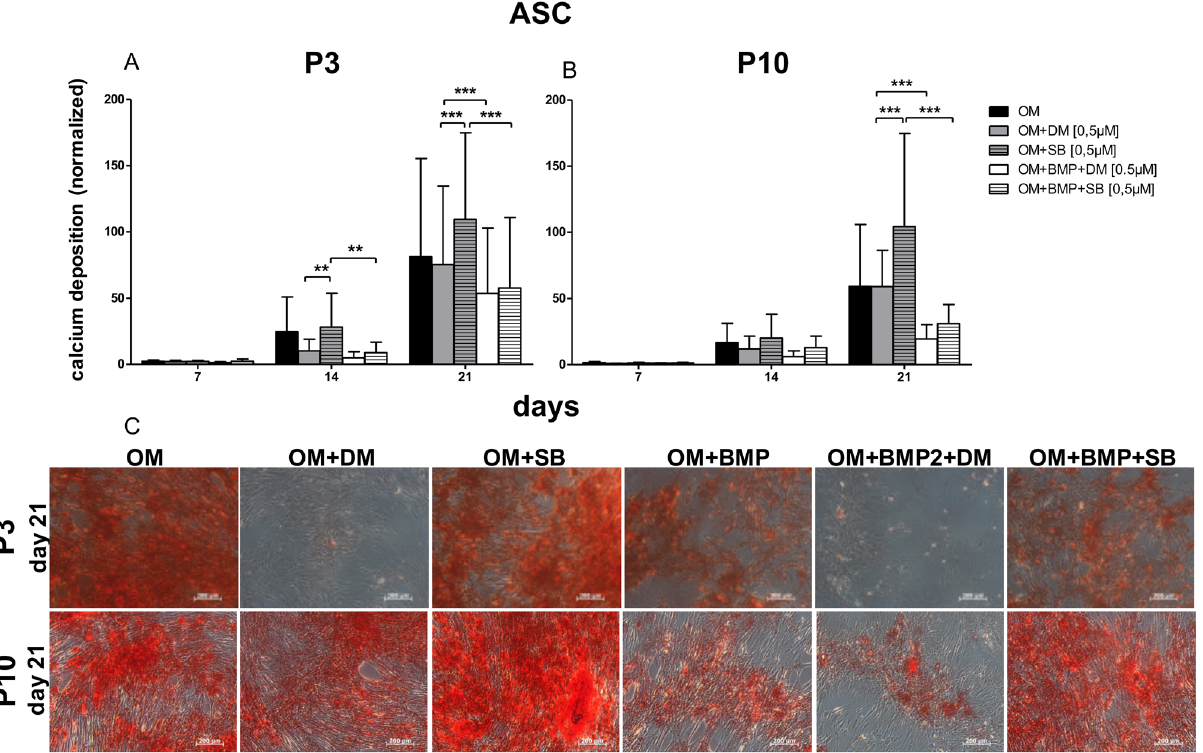
Figure 6. Comparison of the ASC osteogenic differentiation potential at P3 versus P10. ( A ) Evaluation of osteogenic differentiation potential in P3 with alizarin red s. At day 14 the inhibition of the TGF-β signaling with SB431542 (OM + SB) was significantly superior to the inhibition of BMP signaling with dorsomorphin (OM + DM). And the inhibition of the TGF-β signaling significantly was better than the inhibition of TGF-β signaling and the simultaneous induction of BMP signaling with BMP-2 (OM + BMP + SB). ( B ) Evaluation of osteogenic differentiation potential at P10 with alizarin red s. Inhibiting the TGF-β signaling with SB431542 (OM + SB431542) generated the best osteogenic differentiation potential, at day 21 and was significantly superior to an additionally application of BMP-2 (OM + BMP + SB431542). And the inhibition of BMP signaling with dorsomorphin in the course of the osteogenic differentiation (OM + DM) was significantly superior to the treatment with dorsomorphin supplemented with BMP-2 (OM + BMP + DM). Black bars are ASC differentiated with osteogenic standard differentiation media (OM). Grey bars are ASC differentiated with OM and dorsomorphin (OM + DM). Stacked grey bars are ASC differentiated osteogenically and treated with SB431542 (OM + SB). White bars are ASC coincubated with OM and BMP-2 with the inhibitor dorsomorphin (OM + BMP + DM). Stacked white bars are DSC differentiated with OM, BMP-2 and the inhibitor SB431542 (OM + BMP + SB). Bars represent mean ± SD of three donors. ** p < 0.01 as compared to the respective sample. *** p < 0.001 as compared to the respective sample. ( C ) Visualized comparison of osteogenic differentiation potential of DSC at P3 and P10. Evaluation was performed with alizarin red s on day 21. Shown is one representative illustration of at least six identical results. The image scales represent a length of 200